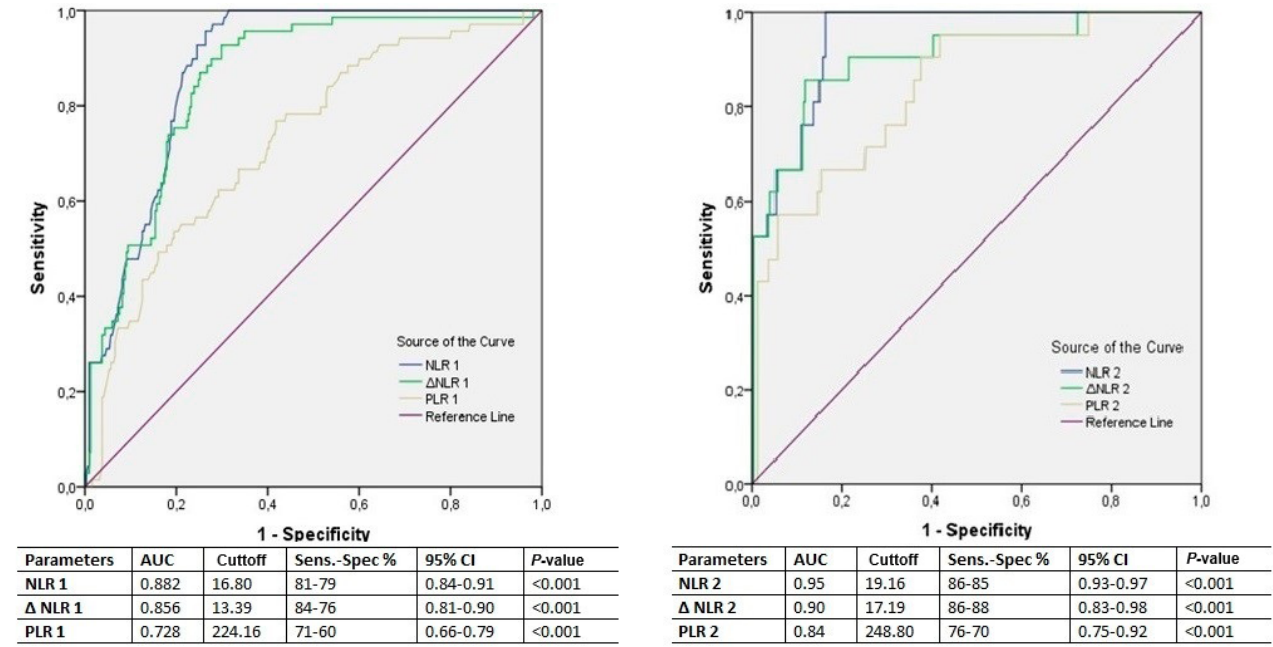
Fig. 2 - Receiver operating curve analysis for postoperative neutrophil-lymphocyte ratio (NLR), delta(Δ)-NLR, and platelet-lymphocyte ratio (PLR) values for postoperative days one and two, regarding occurrence of acute kidney injury on the subsequent days of hospital stay. AUC=area under the curve; CI=confidence interval; Sens.=sensitivity;